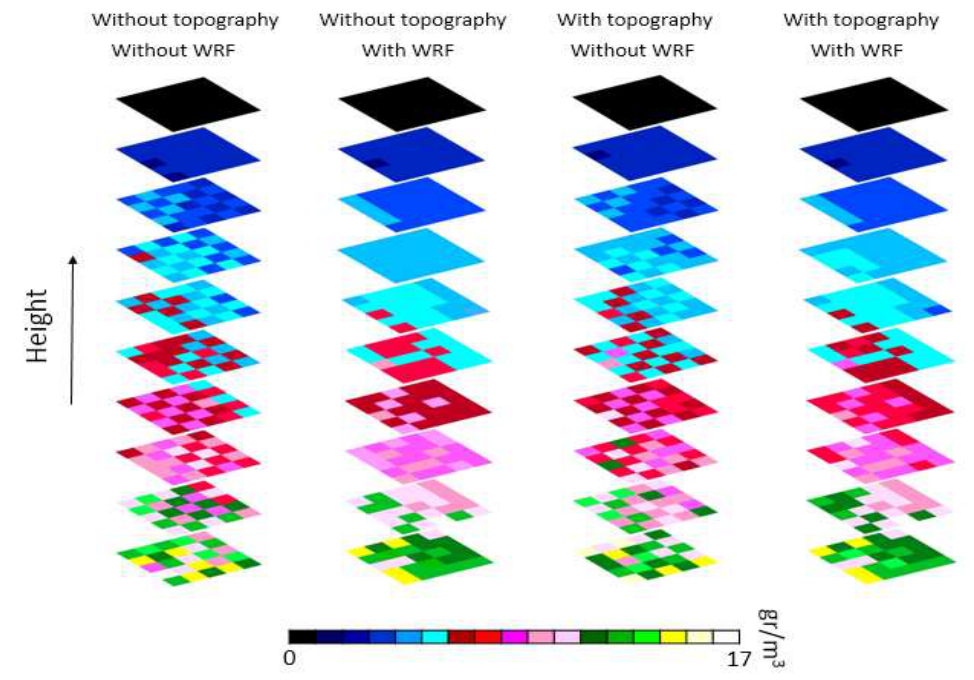
Figure 10. An example of the obtained WVD field .